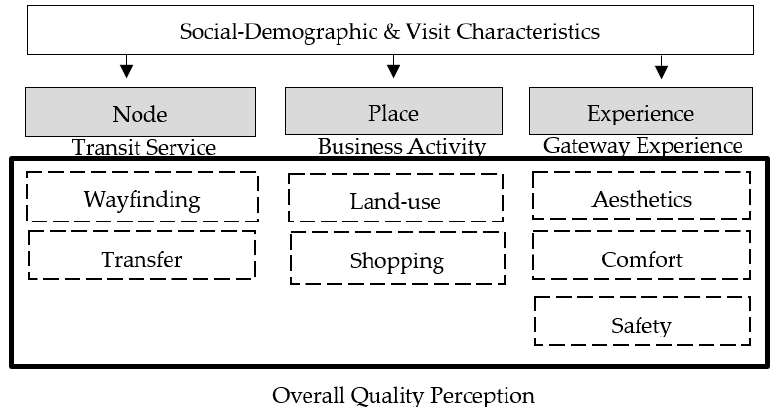
Figure 2. Conceptual model.